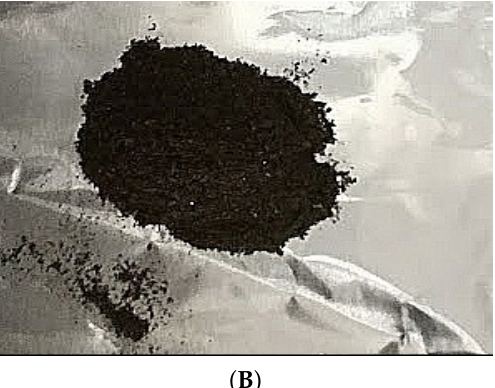
Figure 2. Visual confirmation of biosynthesized nanoparticles. ( A ) The color change represents the preliminary confirmation of silver nanoparticles. ( B ) Purified AgNPs obtained after drying.